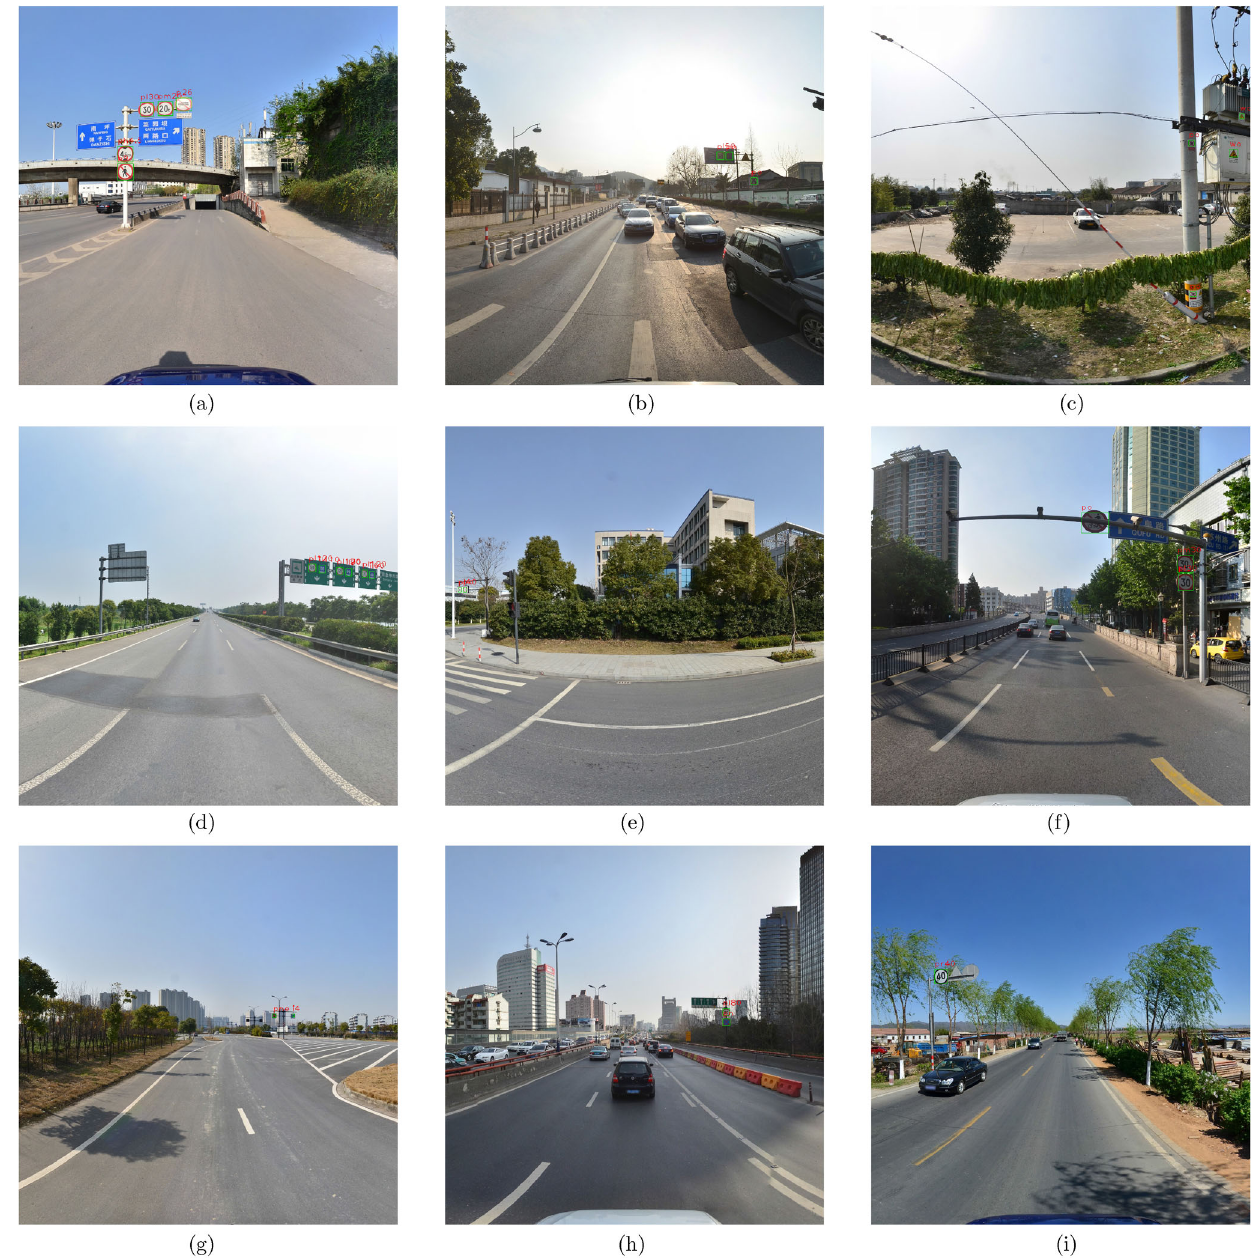
Fig. 5 Detection results. Objects are surrounded by green boxes with red class captions next to them. In real-driving scenes, traffic signs are very small from the perspective of a wide-angle lens, so are hard to be detected. The proposed framework is capable of recognizing multiple very tiny target objects from more than 200 classes in 2048 × 2048 images. Their changing and varied shapes, perspective, and illumination, again well demonstrate the difficulty of this dataset. The detector is also relatively invariant to deformation caused by the